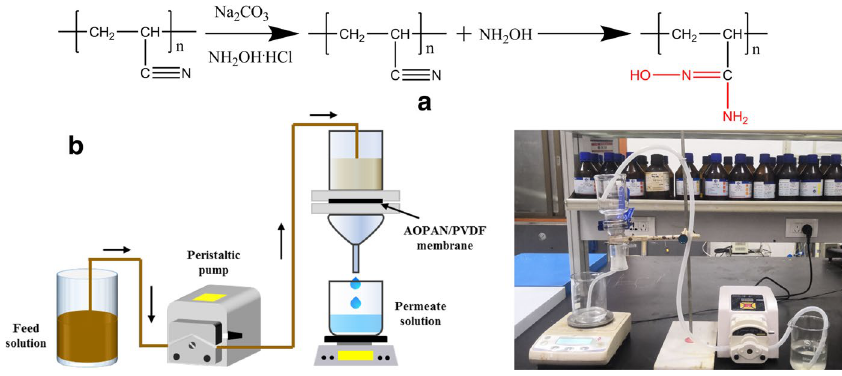
Fig. 1 Routes for a PAN nitrile conversion to amidoxime and b the schematic and picture of the membrane filtration